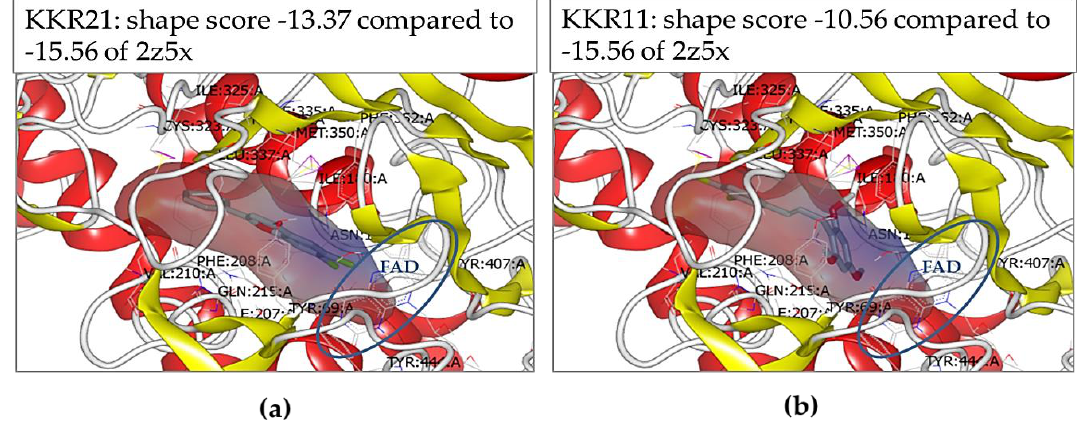
Figure 4. Docking conformation within human MAO-A crystal structure active site; docked KKR21 ( a ) and KKR11 ( b ) are the gray molecules. The active site zones include the lipophilic zones (brown), the hydrophilic zones (blue), and the neutral zones (gray). The cofactor flavin adenine dinucleotide (FAD) is in the blue ring. Table 3. Predicted responsible reversible interactions between MAO-A active site residues and KKR21 and KKR11; involved amino acid residues, cofactor, and water molecules in KKR21, KKR11, and the standard ligand harmine (2Z5X). The hydrophobic interactions are compared to 2Z5X, which was re-docked within the same site.